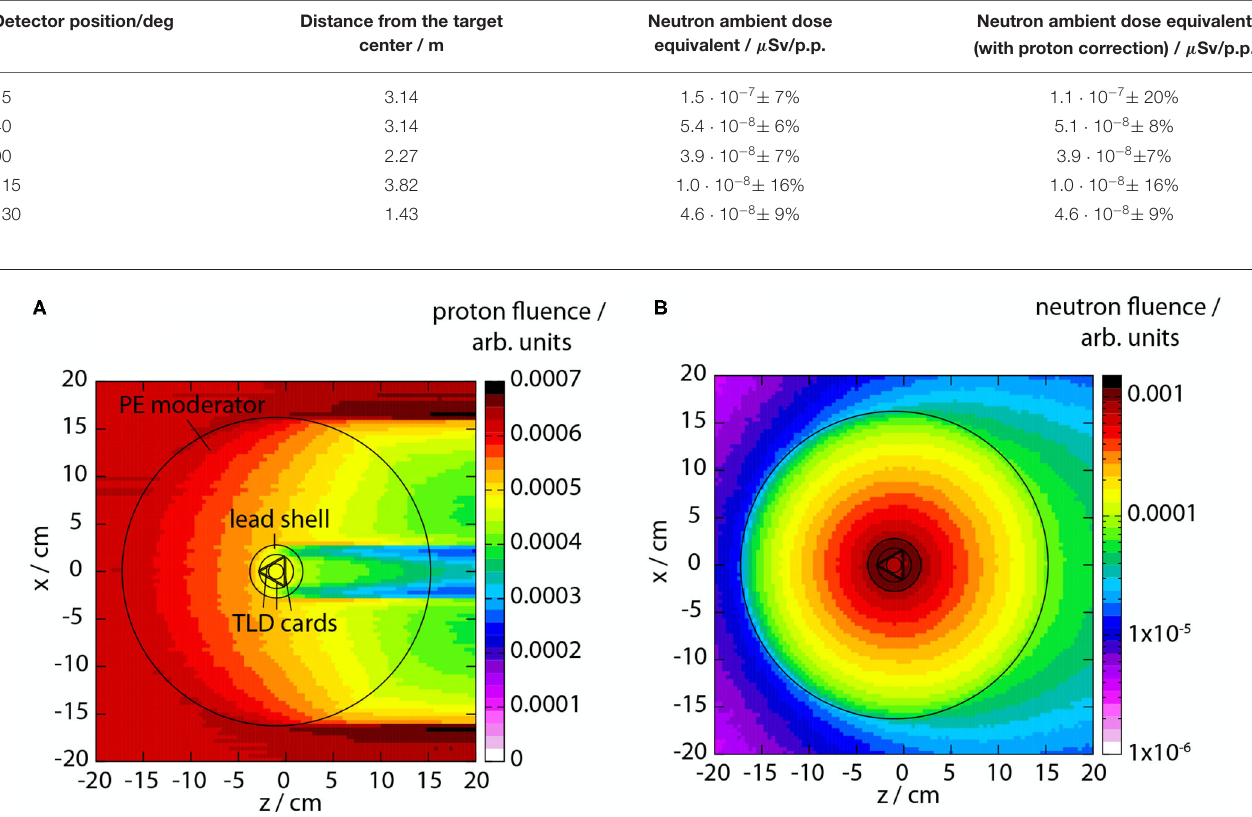
Frontiers in Physics |